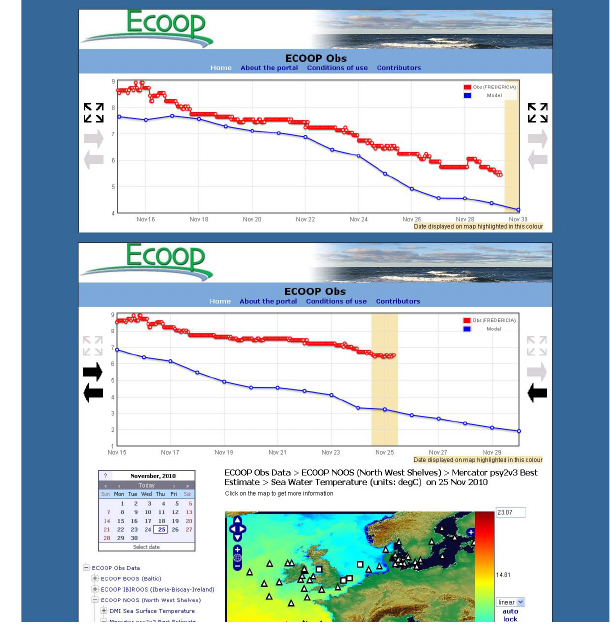
Fig. 9. Portal screenshot showing a timeseries of sea water tempera- ture (red line, two-hourly data feed) from the Frederica platform off the East coast of Denmark (solid black triangle) and from the Mer- cator psy2v3 model (blue line, daily average). The lower timeseries is from 25 November, and the upper timeseries is from 30 Novem- ber. Note that the more recent timeseries represents a best estimate based on more available observed data which have been assimilated into the model, and hence shows a better fit with the Frederica in situ data